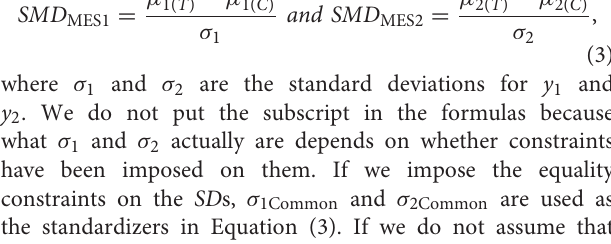
Frontiers in Psychology |